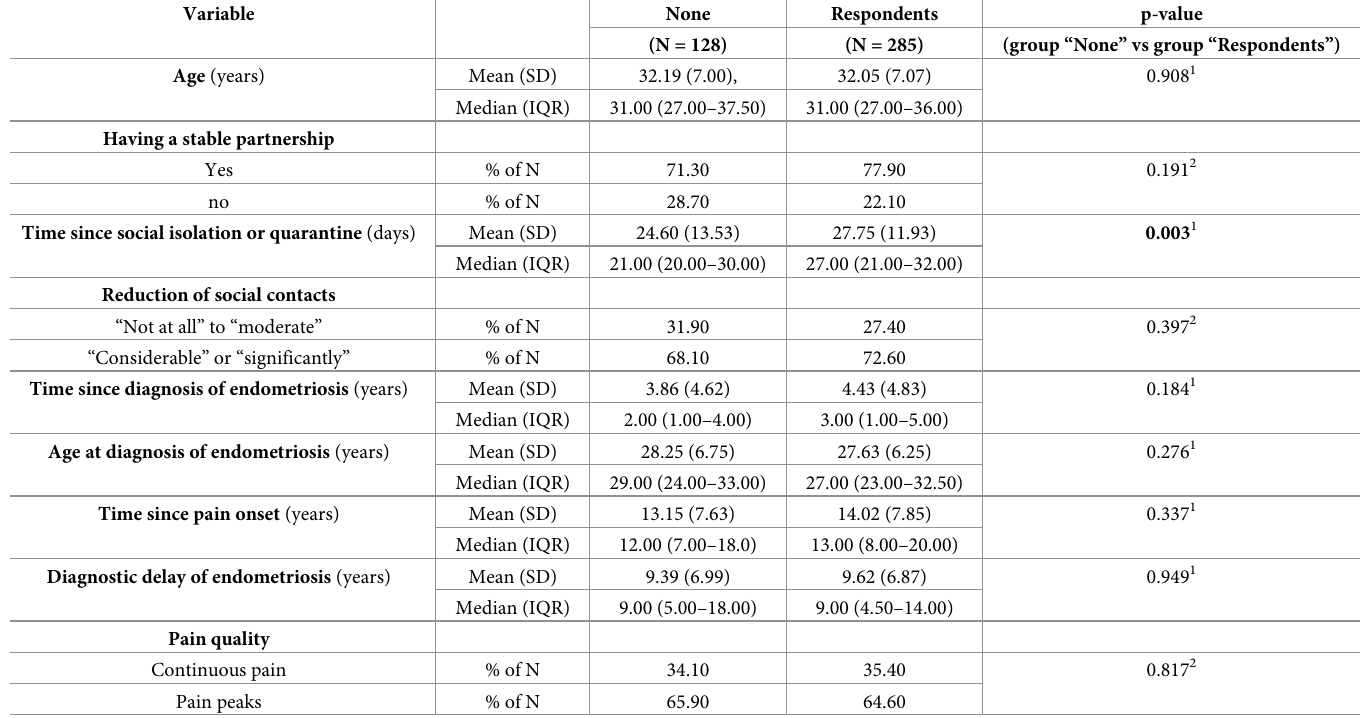
Table 1. Demographic and clinical characteristics of the total study sample showing differences between those participants who did not complete any question regarding pain intensity, pain induced disability, pain perception or social support (group “None”) versus those who completed at least one of the questions (group